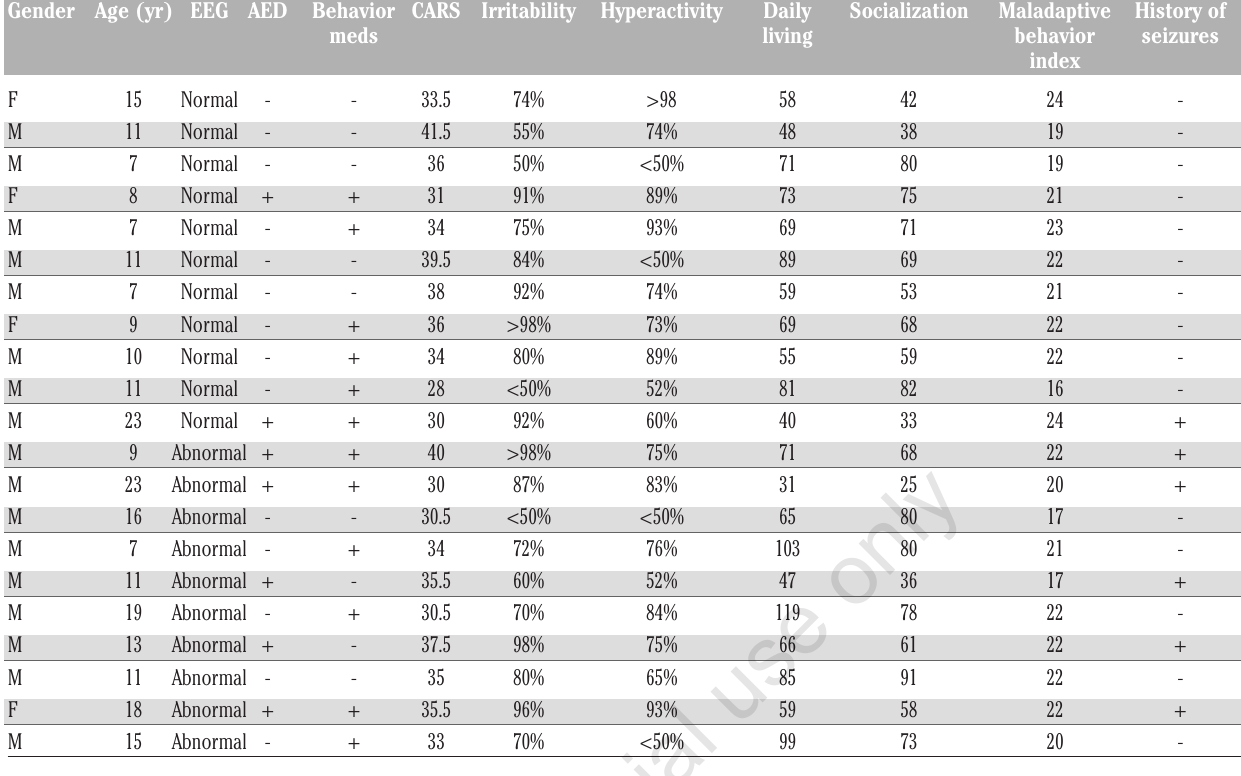
Table 1. Results of parental questionnaires indicating patient age, EEG result, presence of anti-epileptic medication, behavior modifica- tion medications, questionnaire scores and history of seizures.